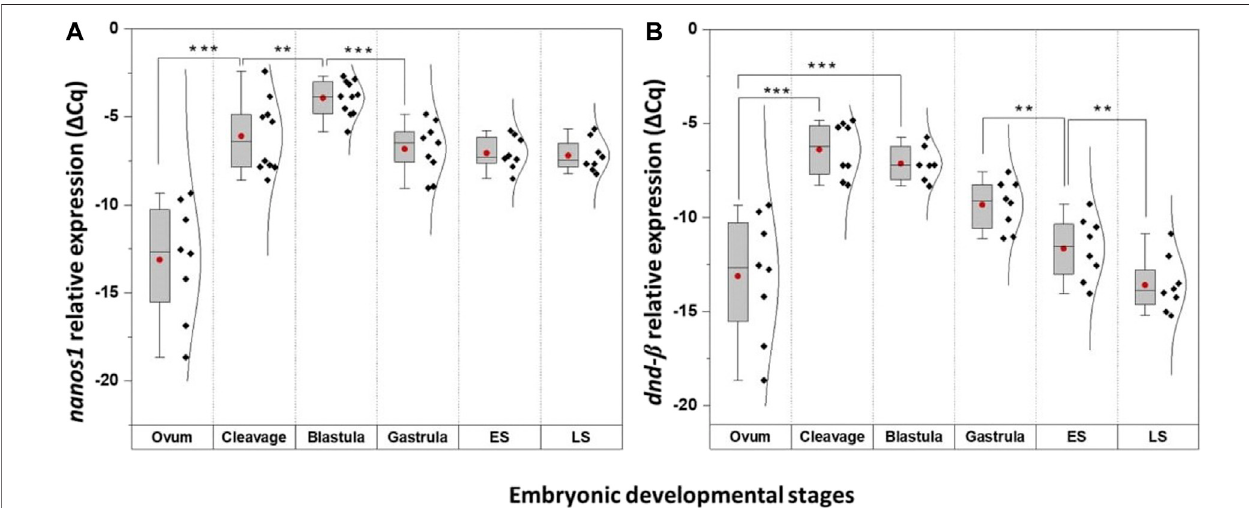
FIGURE6| Thetemporalexpressionof nanos1 and dnd- β atselectembryonicstagesof G.holbrooki .Thepanelrepresentingquantitativeexpressionof nanos1 (A) and dnd- β (B) in six embryonic developmental stages of G. holbrooki . ES, early somitogenesis; LS, late somitogenesis. The dots and the line within the bars indicate mean and median of the data presented within the groups. The normal distribution curves are given in the global expression plots. The asterisks show the level of signi fi cance between the marked groups; Tuckey ’ s HSD, * (cid:1) 0.05, ** (cid:1) 0.01, *** (cid:1) 0.001.